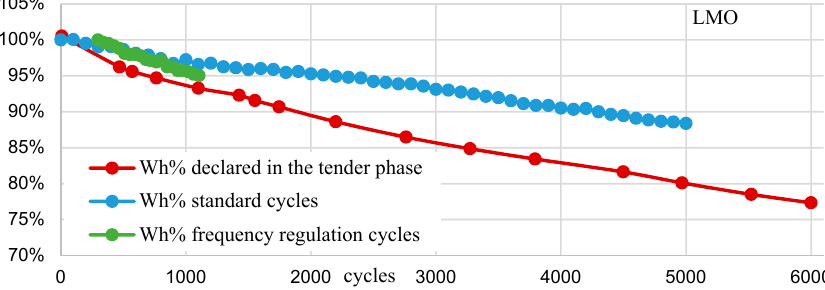
Figure 9. Lithium manganese oxide (LMO) technology: comparison between the expected ageing, declared in the tender phase, and the ageing after the standard and frequency regulation cycles.